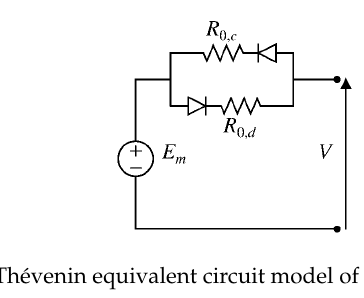
Figure 5. Measured and simulated parameter values for the Figure 4 model, as a function of state-of- charge (SOC). ( a ) No-load voltage E m ; and ( b ) charge and discharge resistances R 0, c and R 0, d .